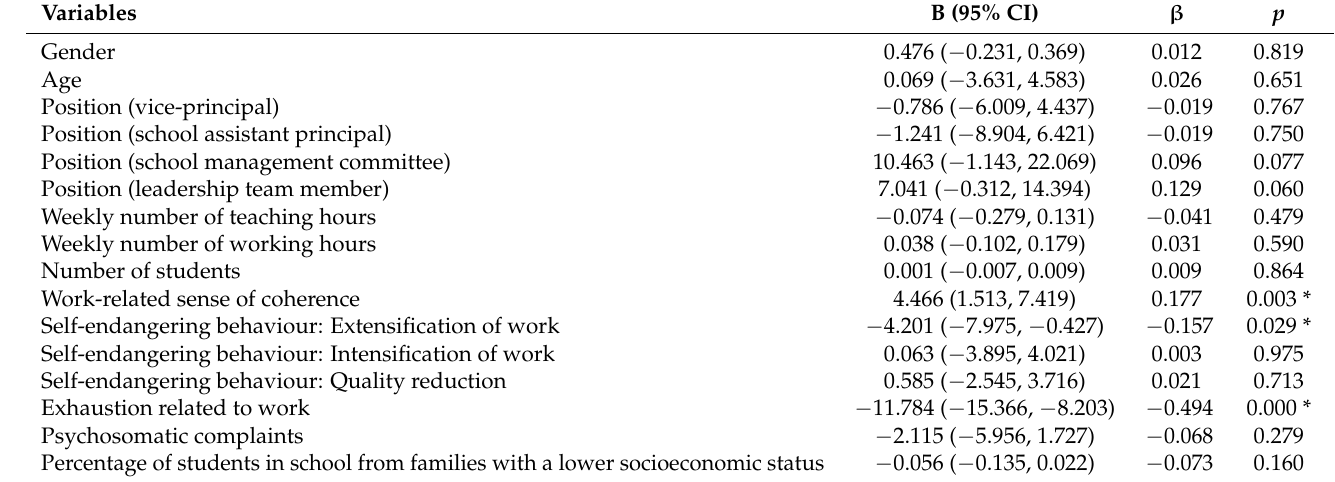
Table 5. Factors associated with the level of well-being via multiple linear regression